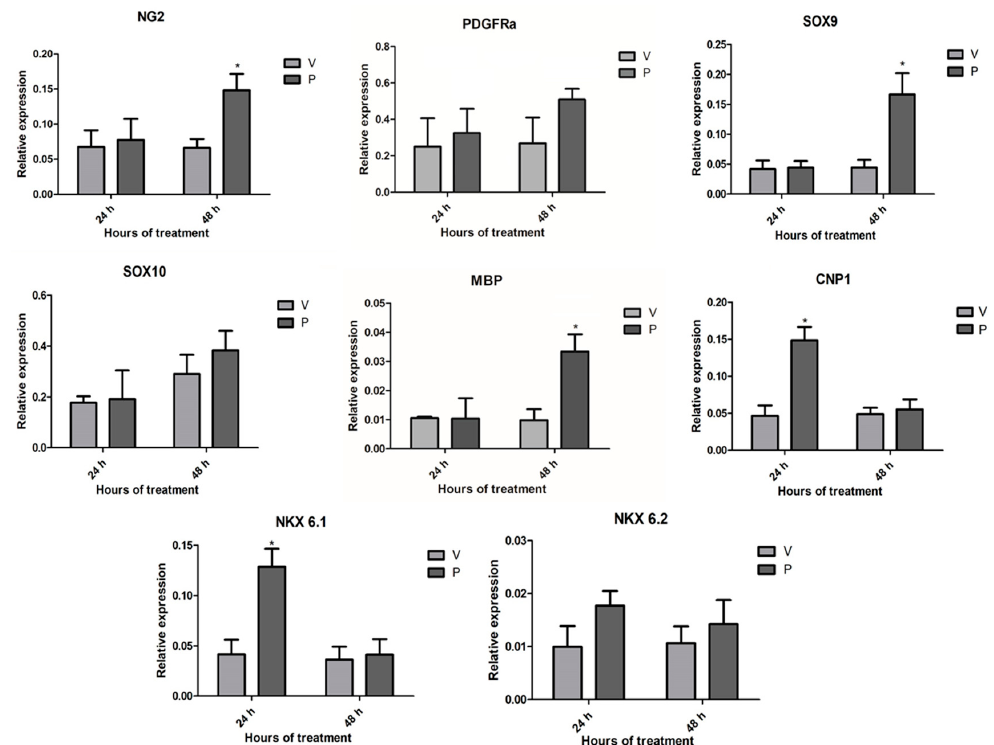
Figure 5. Progesterone upregulates the expression of oligodendroglial genes. The graphs show the relative gene expression (normalized to the 18S gene expression) of the NG2, PDFGR, SOX9, SOX10, MBP, 2’,3’-cyclic-nucleotide 3’-phosphodiesterase (CNP1), NKX 6.1, and NKX 6.2 genes obtained by RT-qPCR after treating OPC with P4 (10 nM) and vehicle (DMSO 0.01%) for 24 and 48 h. Results are expressed as the mean ± S.E.M. n = 3; * p < 0.05 vs. vehicle.